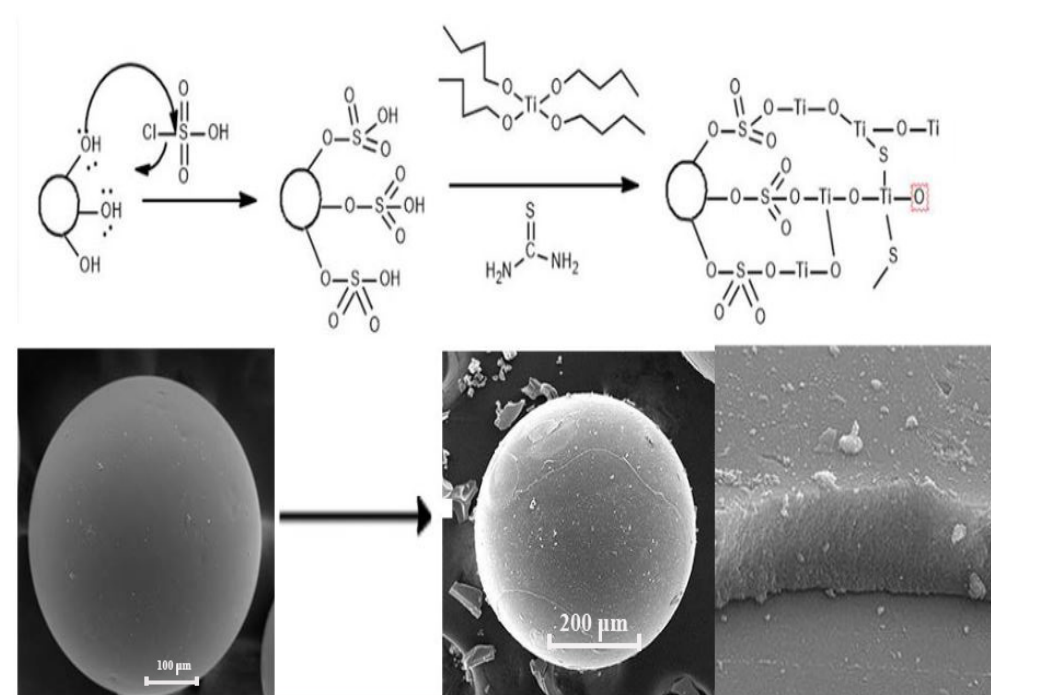
thin layer film coated on silica sulfuric acid 2